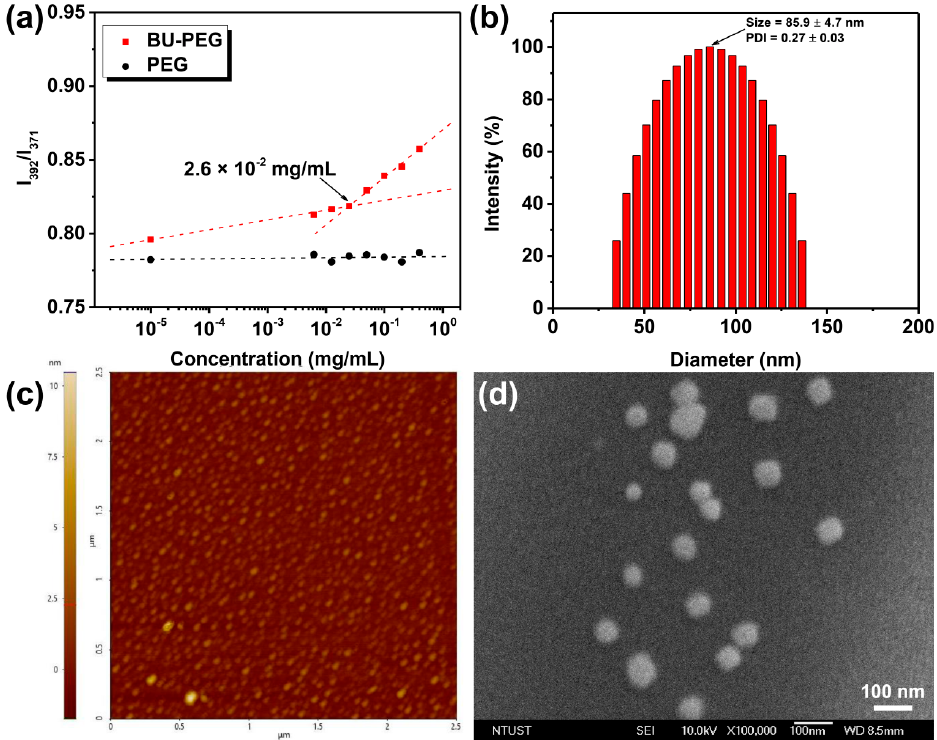
Figure 1. ( a ) Determination of the CMC values of PEG and BU-PEG in water in the presence of pyrene. ( b ) Hydrodynamic particle size of the BU-PEG polymer in water as determined by DLS at 25 °C. Surface morphologies of spin-coated BU-PEG polymers obtained by ( c ) AFM and ( d ) SEM at 25 °C.